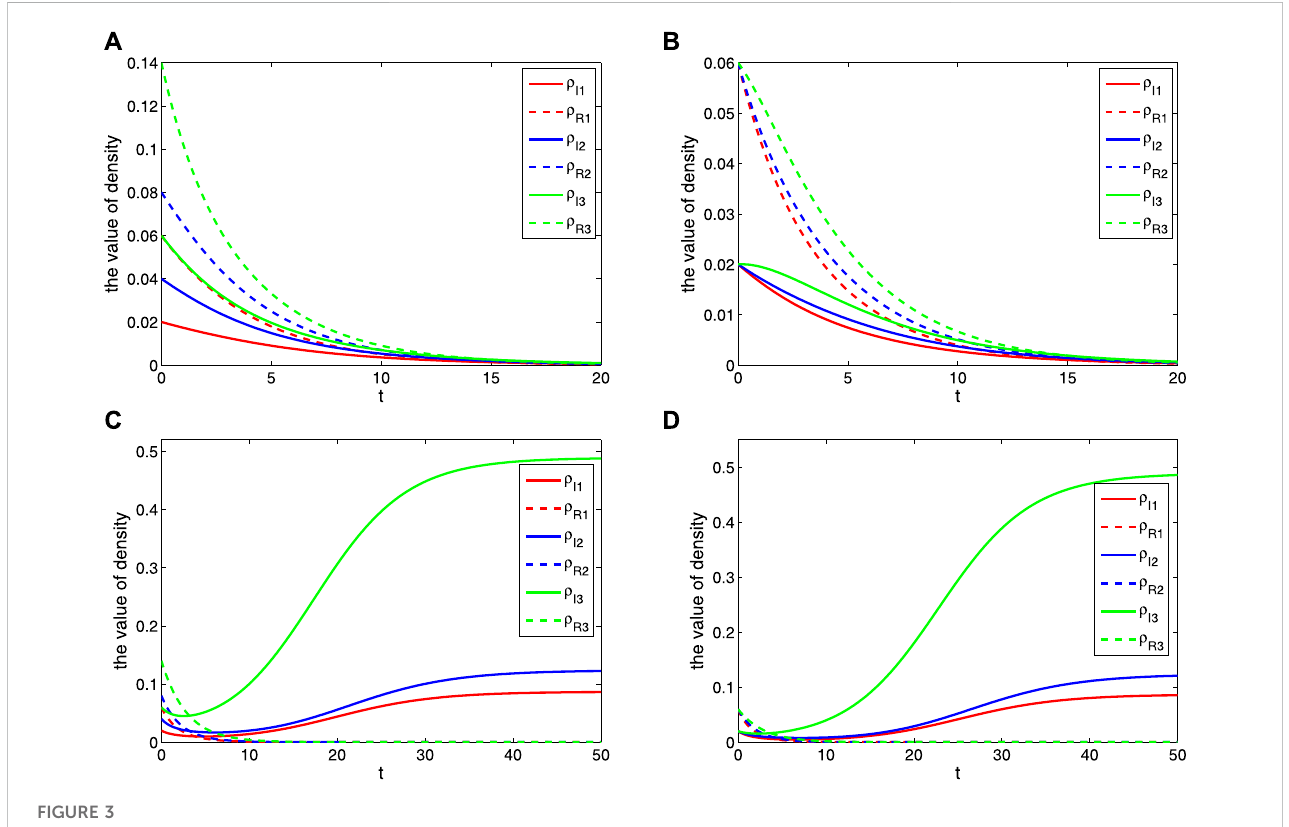
FIGURE 3 Effect of different interaction rates on the stability of rumor